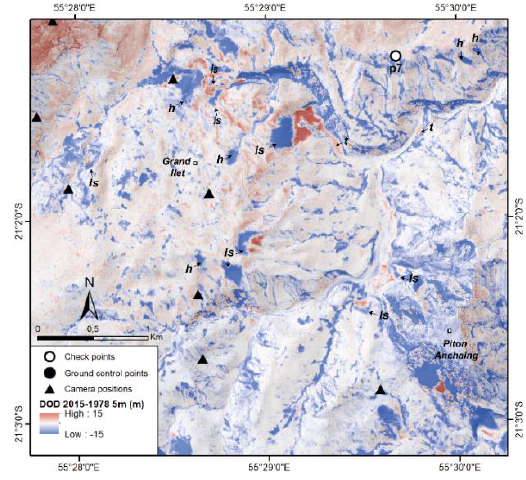
Figure 6. 5 x 5 m Difference of DEM (DOD) comparing a heliborne lidar DTM acquired in 2015, originally at 0.5 x 0.5 m resolution, and the 1978 (all photos, 4 parameters calibration) photogrammetric coverage produced at 0.66 m/pixel. Deep blue (erosion) and red zones (accumulation) reveal major geomorphic or anthropic changes effectively known around Grand Ilet sector in Cirque de Salazie. Some remarkable landforms are pointed by black arrows ls: landslide, h: headward erosion, t: river terraces. The most visible landslide (dual blue/red patch in the centre north) is the 1 Mm 3 Roche à Jacquot landslide triggered by cyclone Béjisa in